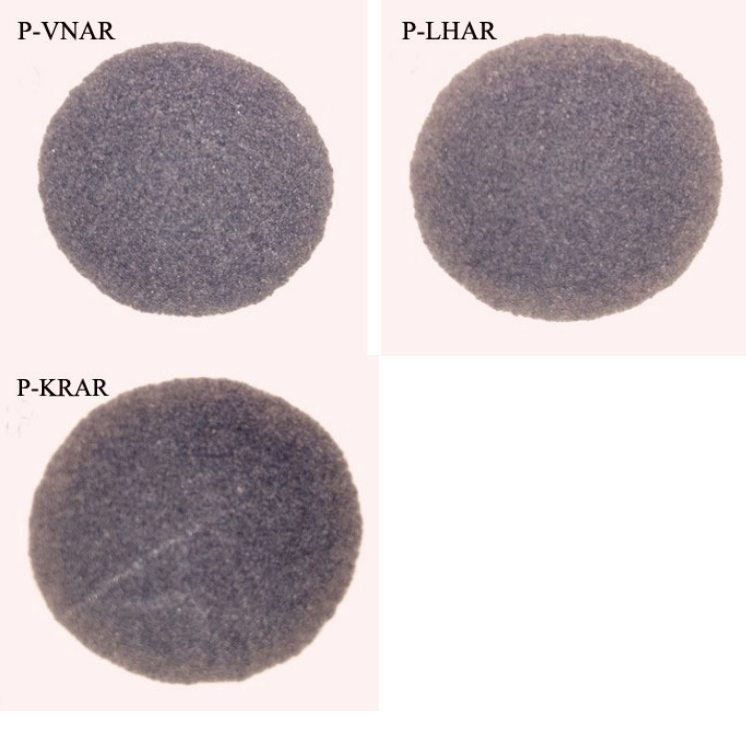
Figure 1. Spot test of the products.